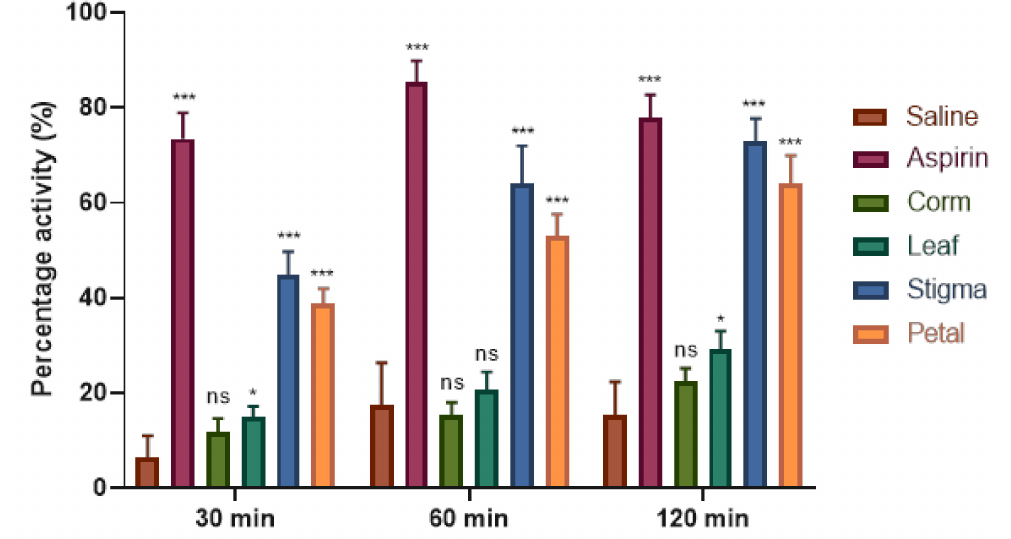
Figure 2. Percentage analgesia of C . sativus ethanolic extracts at selected time period in mice. Each value is represented as mean ± S.D. Where, * p < 0.05, ** p < 0.01, *** p < 0.001 statistically significant relative to control